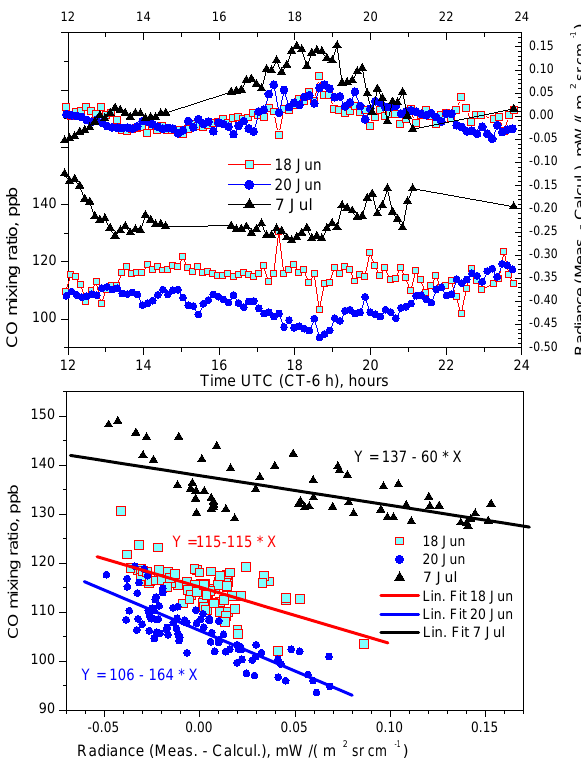
Fig. 6. Top panel: the top three curves (right y -axis) illustrate daily variations of the radiance differences (RD) for three days in 2006 in two transparent windows of the CO band (see Fig. 1). The bot- tom three curves (left y -axis) show the corresponding CO mixing ratio retrieved from the AERI spectra for these days. Bottom panel: the CO and RD points from the top panel that are plotted against each other for each of the three days along with the best fit linear regression